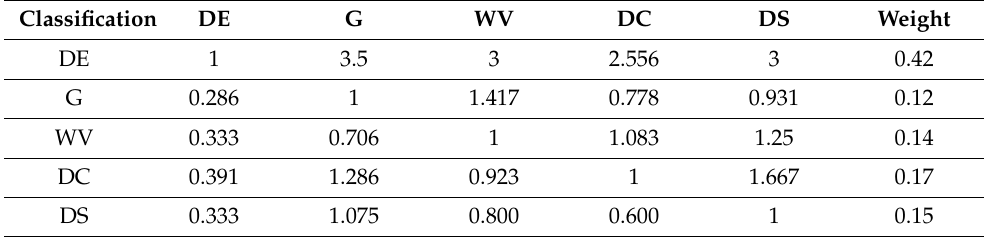
Table 2. Relative comparisons among elements for a temporary road construction.